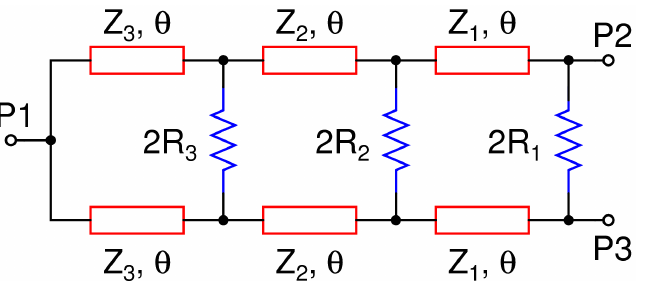
Figure 2. The three-section